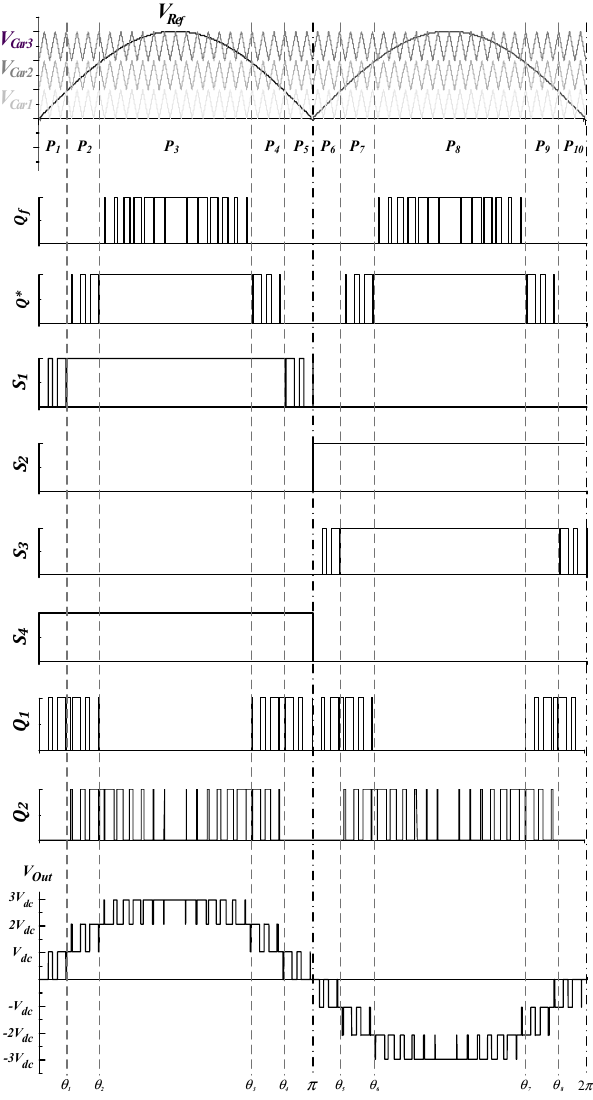
Figure 4. Switching strategy of the 7-Level PWM inverter.